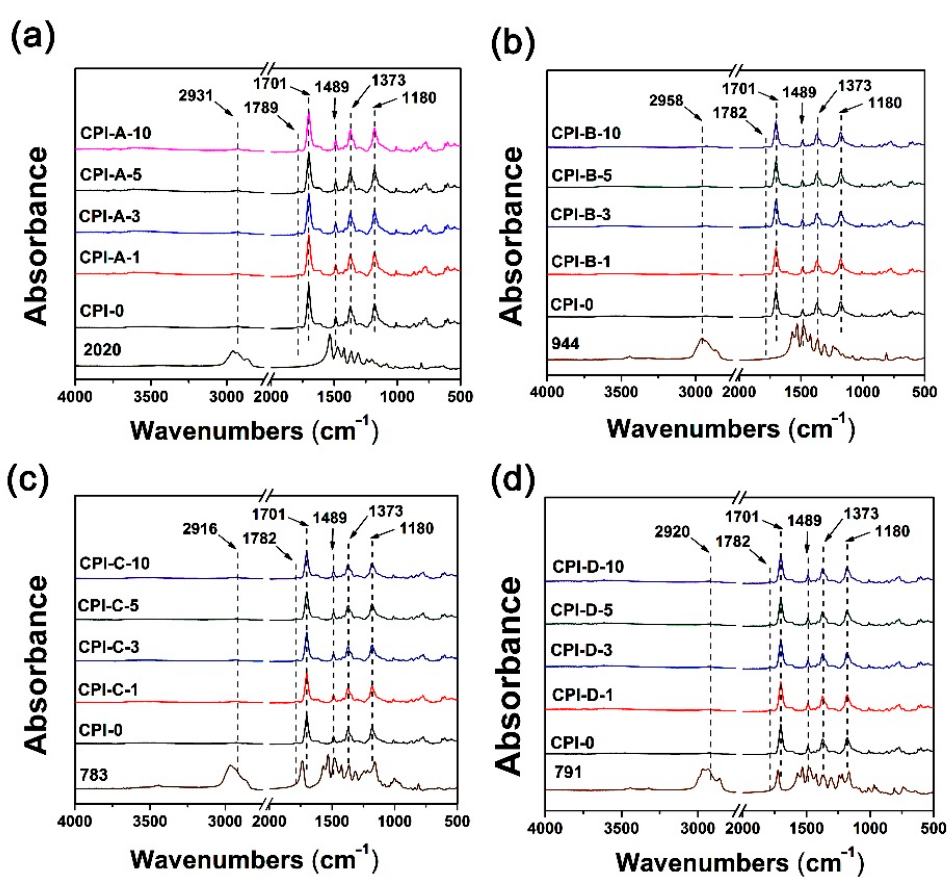
Figure 7. FTIR spectra of CPI/HALS nanocomposite films. ( a ) CPI-A; ( b ) CPI-B; ( c ) CPI-C; ( d ) CPI-D.